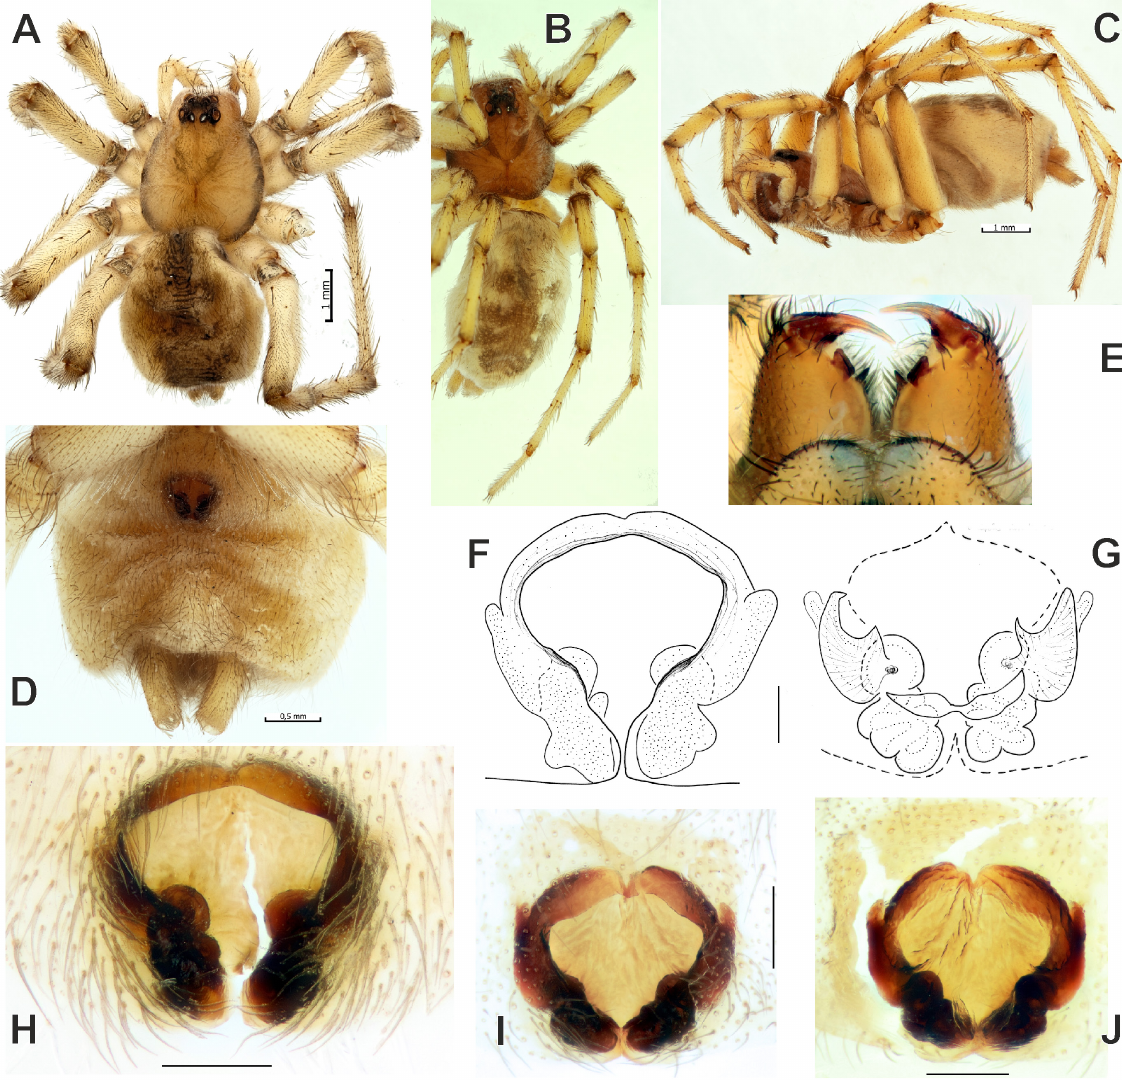
Fig. 5. Callipelis deserticola Zamani & Marusik, 2017, ♀ (A, D–H = specimen from MHNG; B–C, I–J = specimen from SMF). A–C . Habitus, dorsal and lateral views. D . Abdomen, ventral view. E . Chelicerae, posterior view. F, H–I . Epigyne, ventral view. G, J . Epigyne, dorsal view. Scale bars: A, C = 1 mm; D = 0.5 mm; F–G = 0.1 mm; H–J = 0.2